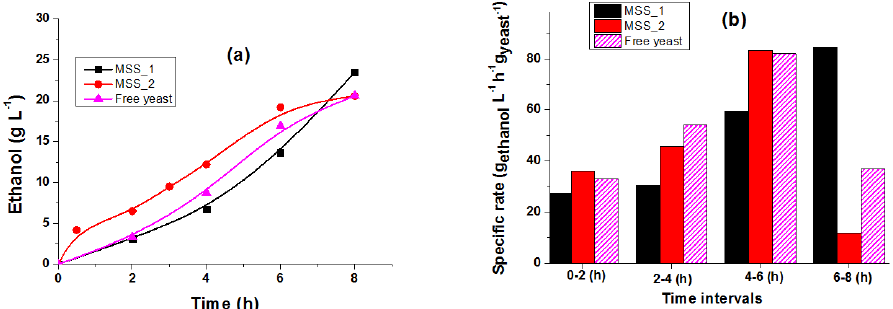
Figure 4. Fermentation of molasses solution with yeast immobilized on MSS and free yeast for ethanol production: (a) ethanol concentration in time; (b) specific rate of fermentation.